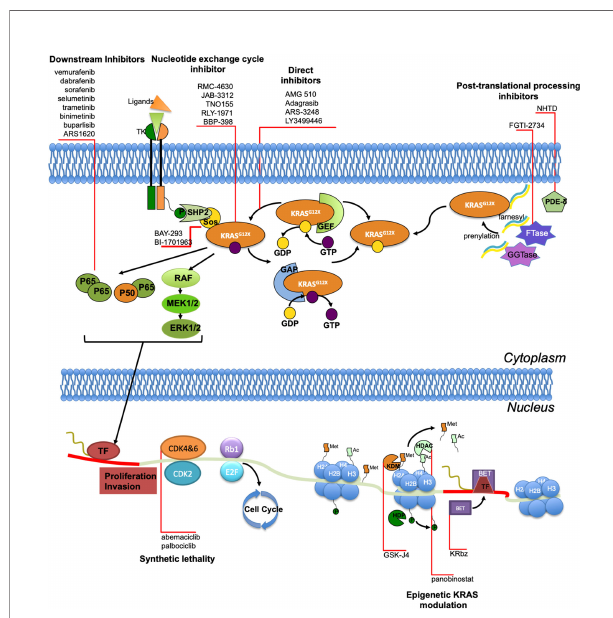
FIGURE 1 | Site of activity of different agents targeting